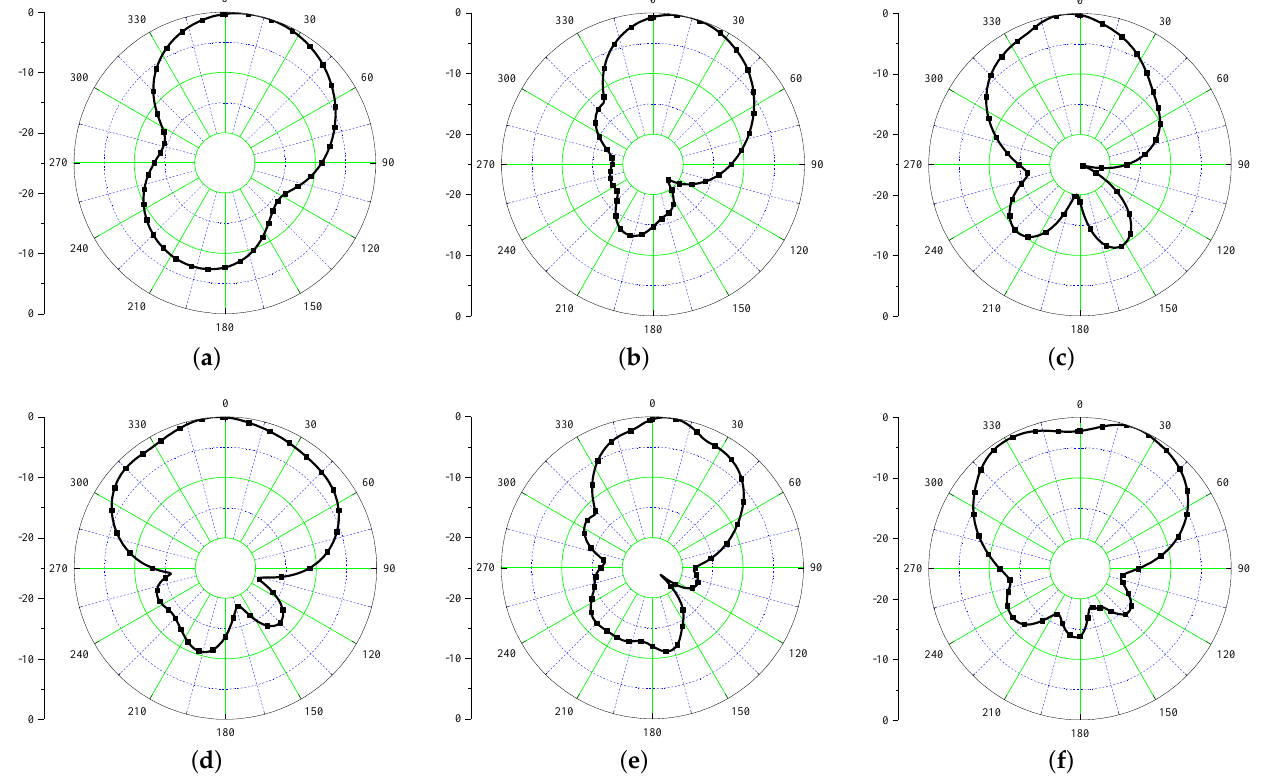
Figure 18. Simulated radiation patterns of conformal antenna (xz plane) at ( a ) 868 MHz ( b ) 3 GHz ( c ) 3.5 GHz ( d ) 4 GHz ( e ) 4.5 GHz ( f ) 5 GHz. Table 5. Comparison of the proposed antenna with the existing literature.